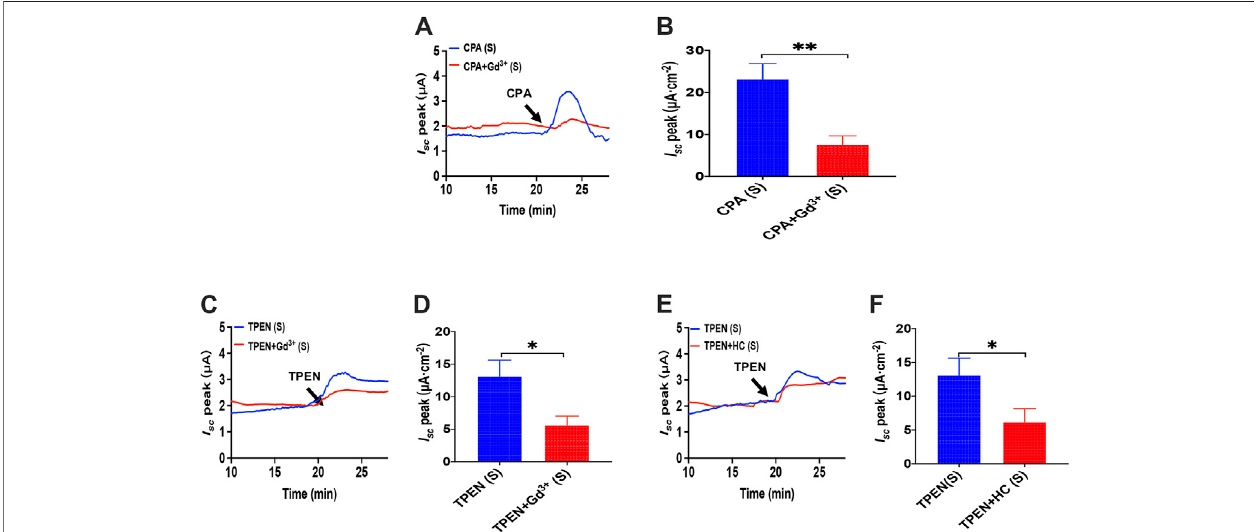
FIGURE 11 | Activator of SOCE in the duodenal epithelium. (A,B) serosal CPA(10 μ M)-stimulated duodenal I sc after addition of GdCl 3 (30 μ M) in the serosal side ( n (cid:2) 6). (C,D) TPEN-stimulated duodenal I sc after addition of GdCl3 (30 μ M) in the serosal side ( n (cid:2) 6). (E,F) TPEN-stimulated duodenal I sc after adding HC067047 (30 μ M)totheserosalside( n (cid:2) 6).Ctrlrepresentsthecontrolwithoutdrugtreatment.Resultsarepresentedasmean ± SE.NS,nosigni fi cantdifferences,* p < 0.05,** p < 0.01 vs. corresponding control by Student ’ s unpaired, two-tailed t-test.